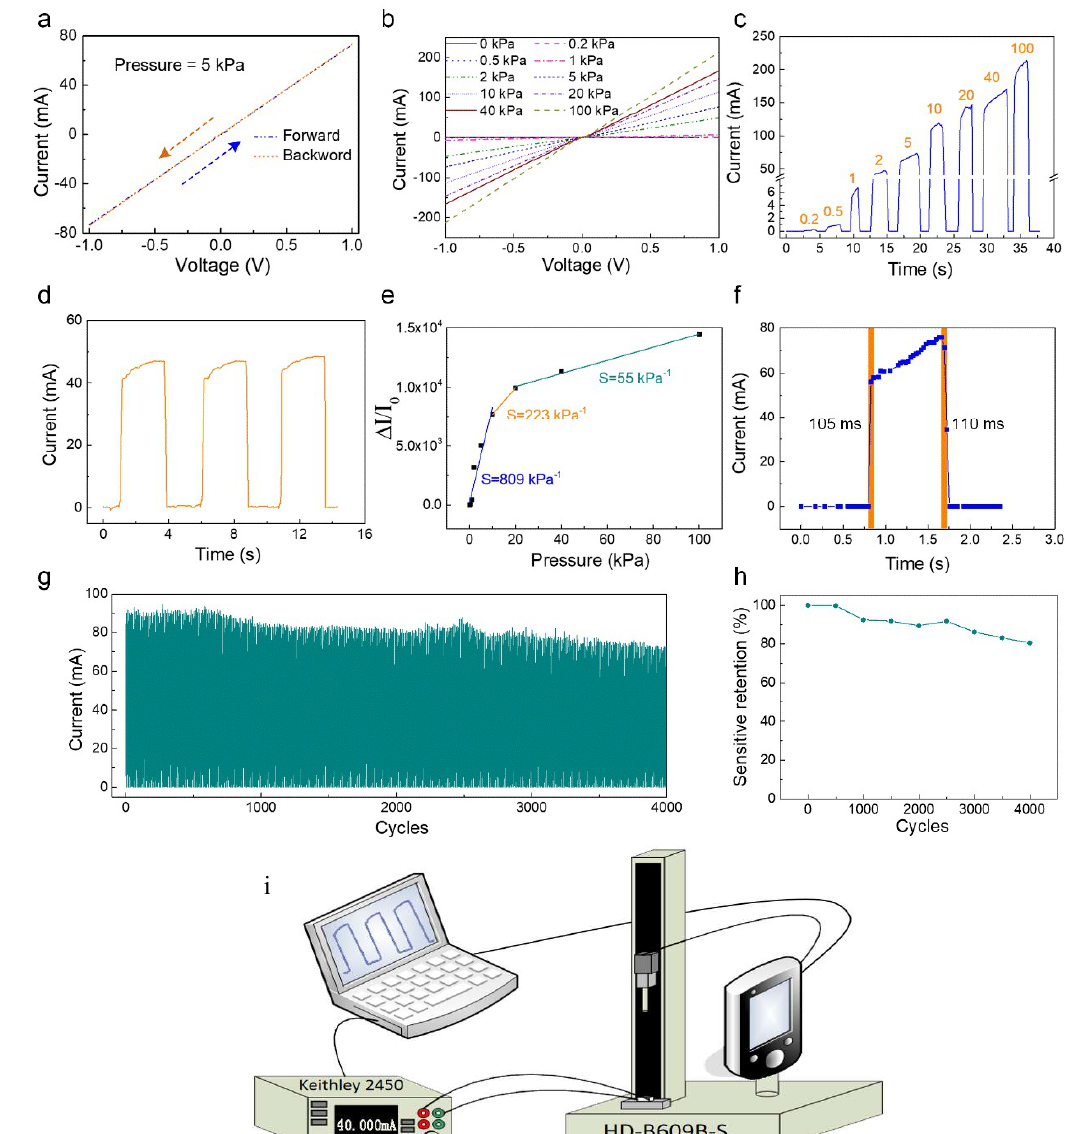
Figure 3. ( a ) I-V measurements at an external pressure of 5 kPa for forward and backward sweepings of voltages from -1 to 1 V. ( b ) The straight-line relationship between the I–V curves for the voltage from -1 to 1 V. ( c ) The I–T curves of the pressure sensor with the various external forces. ( d ) The stability of the pressure sensor. ( e ) The sensitivity of the sensor, demonstrating a high sensitivity of 809 kPa −1 under 10 kPa, 223 kPa −1 in the region of transitional pressure (10–20 kPa), and 55 kPa −1 in the region of high-pressure (20–100 kPa). ( f ) The response time in relation to the loading and unloading pressure of the sensor. ( g ) The durability of this sensor with press-release 4,000 cycles. ( h ) The sensitivity remained well above 80% of the original value, following 4,000 loading–unloading cycles. ( i ) Schematic illustration of the test system.